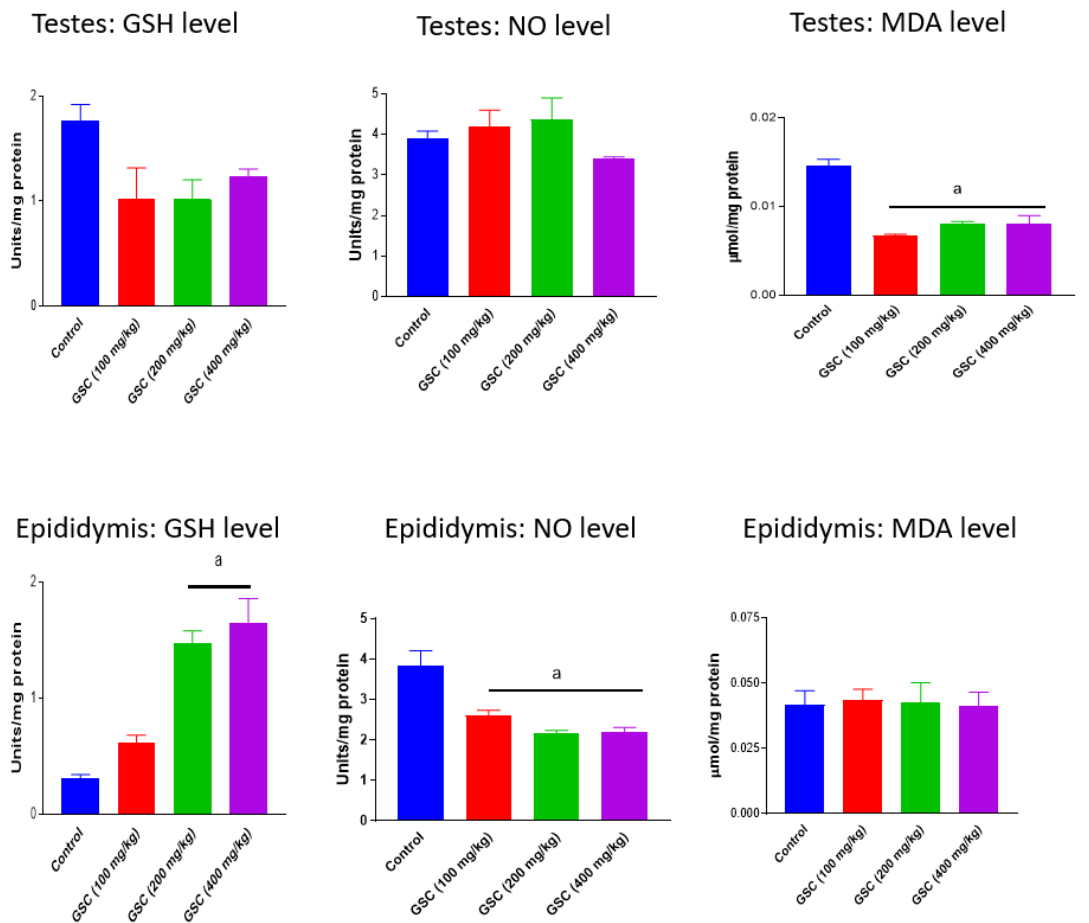
Figure 2. Effect of green-synthesized cellulose (GSC) on oxidative stress parameters in testes and epididymis of rats, Values are expressed as mean ±SEM (n = 5). a Significantly different from control ( p < 0.05). GSH—reduced glutathione; MDA—malondialdehyde; NO—nitric oxide.